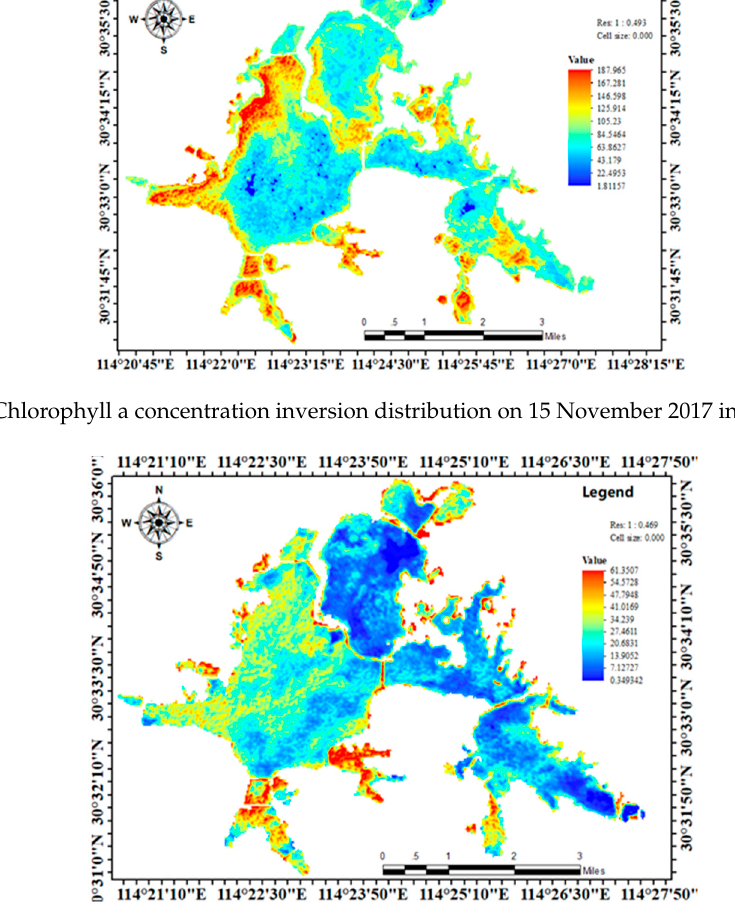
Figure 5. Chlorophyll a concentration inversion distribution on 17 December 2017 in Donghu Lake.